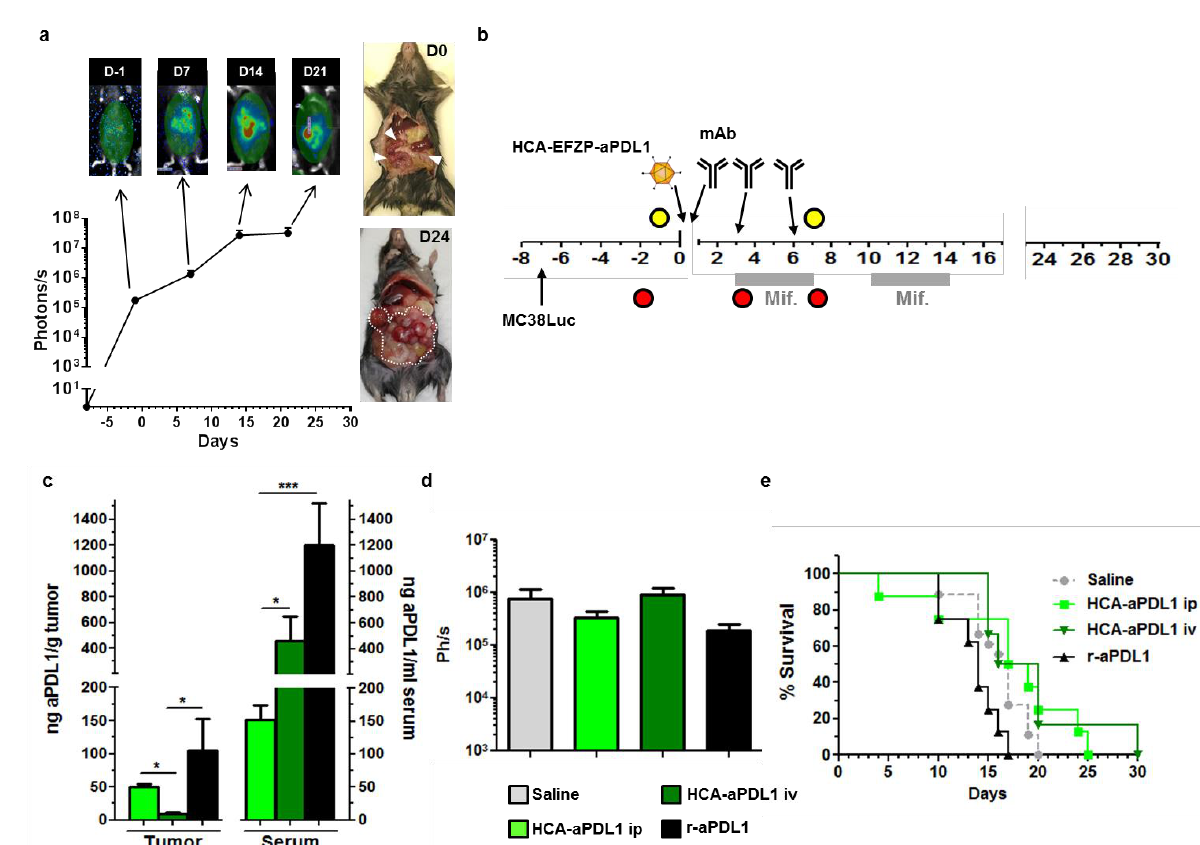
Figure 4. Colorectal cancer peritoneal metastases are refractory to aPD-L1 treatment. ( a ) Characterization of the PC model. I.p. injection of MC38Luc1 cells leads to rapid progression of tumors. Light emission from tumors can be detected by BLI one week after cell implantation (considered as day-1, D-1) and shows a progressive increase during the following 2 weeks. The graph represents quantification (in photons/s) from the abdominal area of mice at different time points ( n = 12 days 0–14, n = 4 day 21). Images on top correspond to representative mice during BLI. The pictures on the right show tumor extension at days 0 and 24. ( b ) Schematic representation of the treatment schedule. The HCA-EFZP-aPD-L1 vector (HCA-aPDL1) was administered at 10 11 vg/mouse by i.p. or i.v. injection ( n = 10 and n = 6, respectively) at day 0 (one week after cell inoculation). Mifepristone induction consisted of 2 cycles during days 3–7 and 10–14. The recombinant aPD-L1 mAb (r-aPDL1) was administered by i.p. injection ( n = 6) on days 0, 3 and 6. Yellow and red circles indicate BLI and blood collections, respectively. ( c ) Additional groups of mice ( n = 6) received the HCA-EFZP-aPD-L1 vector by i.v. or i.p. injection, or the recombinant protein ( n = 5). Mice were sacrificed 10 h after the first mifepristone induction, or 8 h after the last protein administration for quantification of aPD-L1 concentration in serum and tumor extracts. ( d ) Light emission from control and treated mice at day 7. ( e ) Survival curves. * p < 0.05, *** p < 0.001, Mann–Whitney U test. Data are represented as average ± SEM.